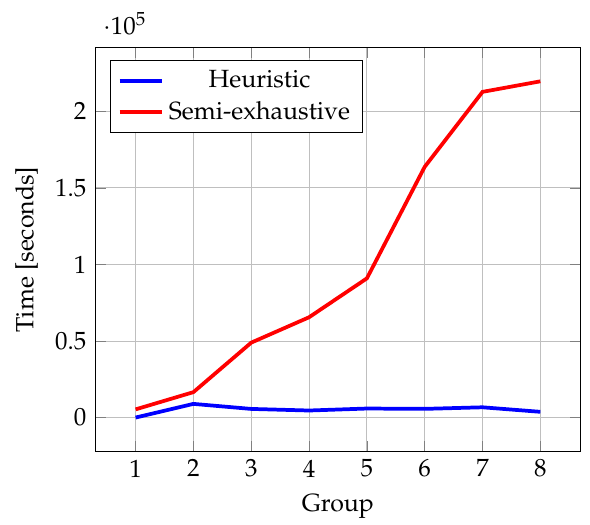
Figure 11. Computational time for each